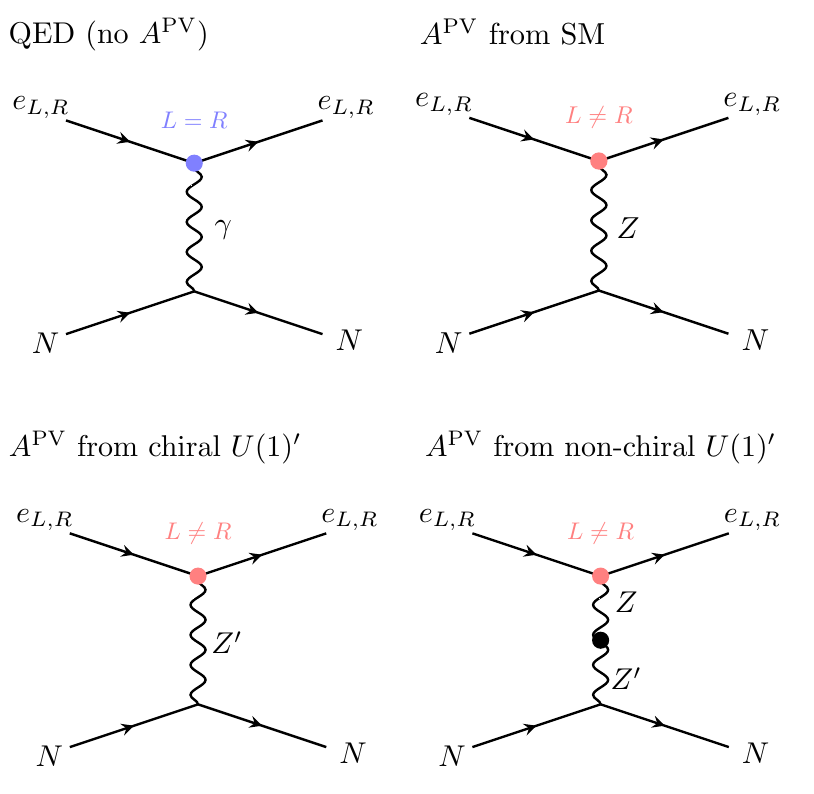
Figure 1 . Leading-order processes for A PV in the SM (top panels) and in the Z 0 models considered here (bottom panels). N denotes either a proton or a nucleus ( 12 C in the context of